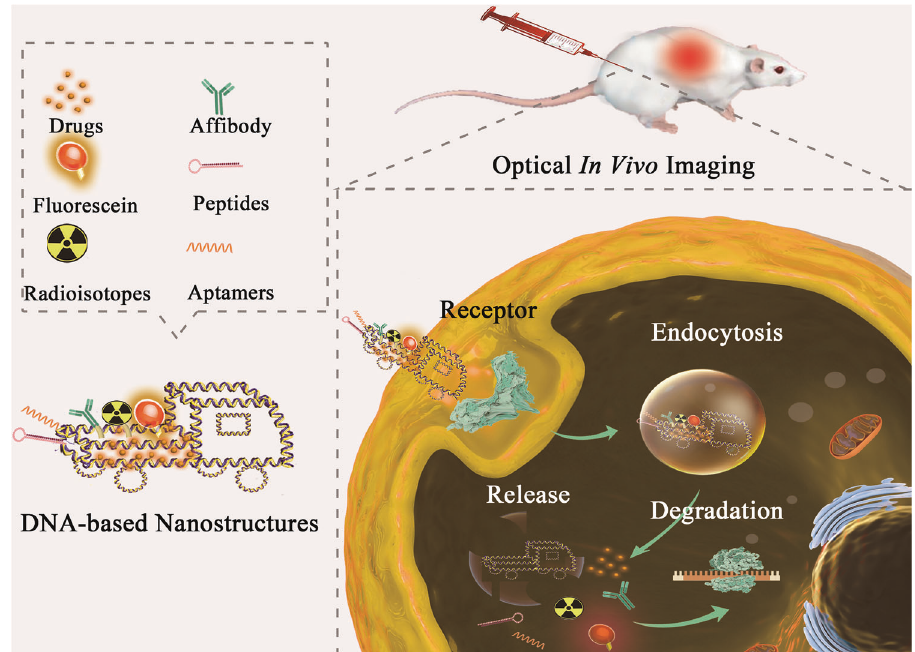
Fig. 5 DNA-based nanostructures on bioimaging and diagnosis. Targeted ligands (e.g., af fi body, peptides and aptamers) and cargoes (e.g., drugs, fl uorescein and radioisotopes) were simultaneously attached to DNA-based nanostructures. After speci fi c combination with biomarkers, the integrates entered target cells and released fl uorescent labels to sensitively detect the diseased